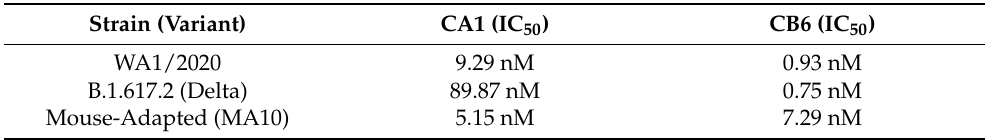
Table 1. Half-maximal inhibitory concentrations (IC 50 ) of plant-made CA1 and CB6 against SARS- CoV-2